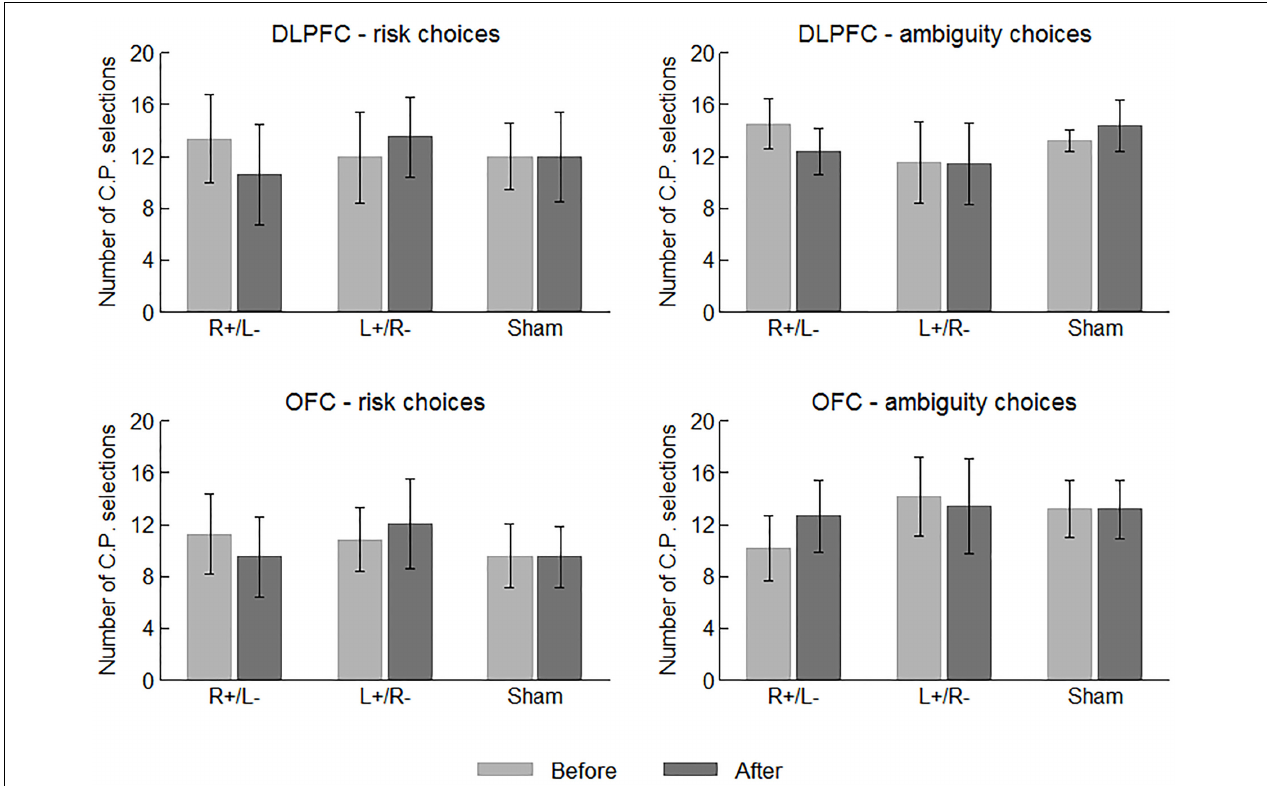
FIGURE 3 | Average numbers of C.P. selections in different choices and treatments before and after the stimulations. Error bars indicate 95% confidence